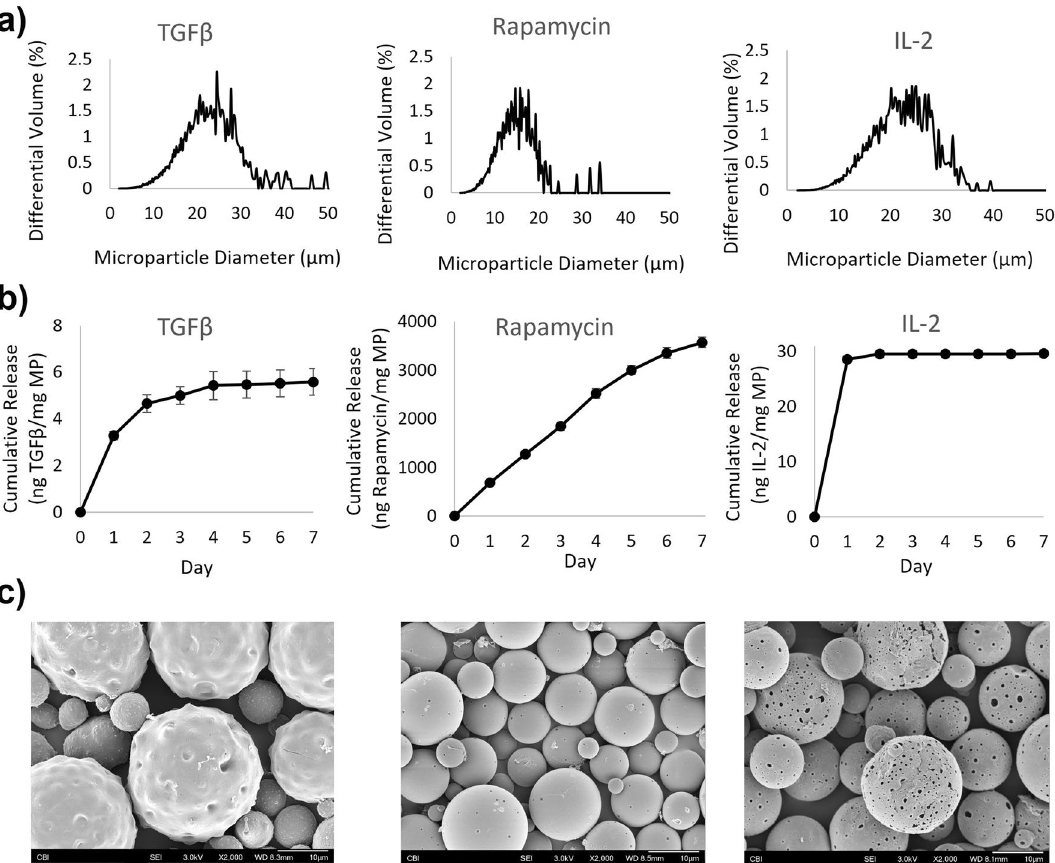
Figure 1. Characterization of the TRI (TGFβ, Rapamycin and IL-2) MPs. ( a ) Size distributions of microspheres (MPs) as measured by volume-impedance method with a Coulter Counter as mean ± standard deviation for TGFβ MPs (21.5 µm ± 6.8 µm), Rapamycin MPs (14.6 µm ± 6.8 µm), and IL-2 MPs (20.8 µm ± 6.1 µm). All Coulter Counter sigma counts were greater than 1000. ( b ) In-vitro release kinetics at 37 °C (n = 3) presented